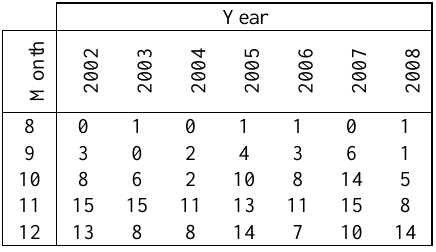
Table 2 classifies variation range of Chl-a, Kd490, nFLH, and HOCI in the RT and normal periods. The units of Chl-a, K d490 , nFLH, and HOCI are mg.m -3 , m -1 , mW.cm -2 .µm -1 .sr -1 ,